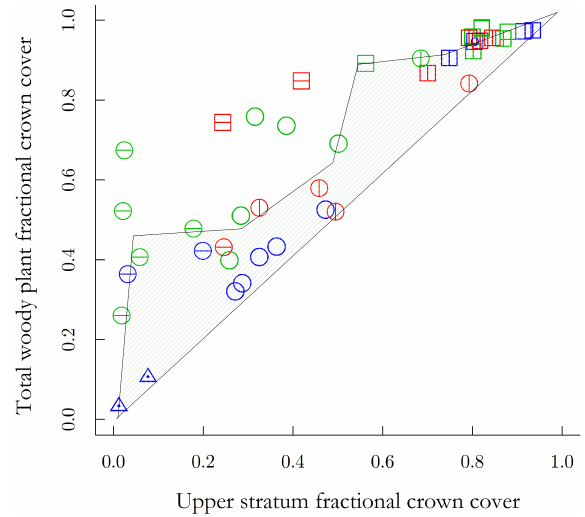
Figure 4. Fractional cover of all woody layers combined (including seedlings) vs. the fractional cover of the upper stratum only ( ζ U ; all trees with D > 0 . 1m). The upper (disjointed) line represents the result from a segmented regression fit to the data ( r 2 = 0 . 84) with the bottom line representing the 1 : 1 relationship. The hatched area therefore shows the average difference between the two estimates for which the area is greatest at ζ U (cid:46) 0 . 25 and 0 . 55 (cid:46) ζ U (cid:46) 0 . 80. Sym- bols as in Fig.